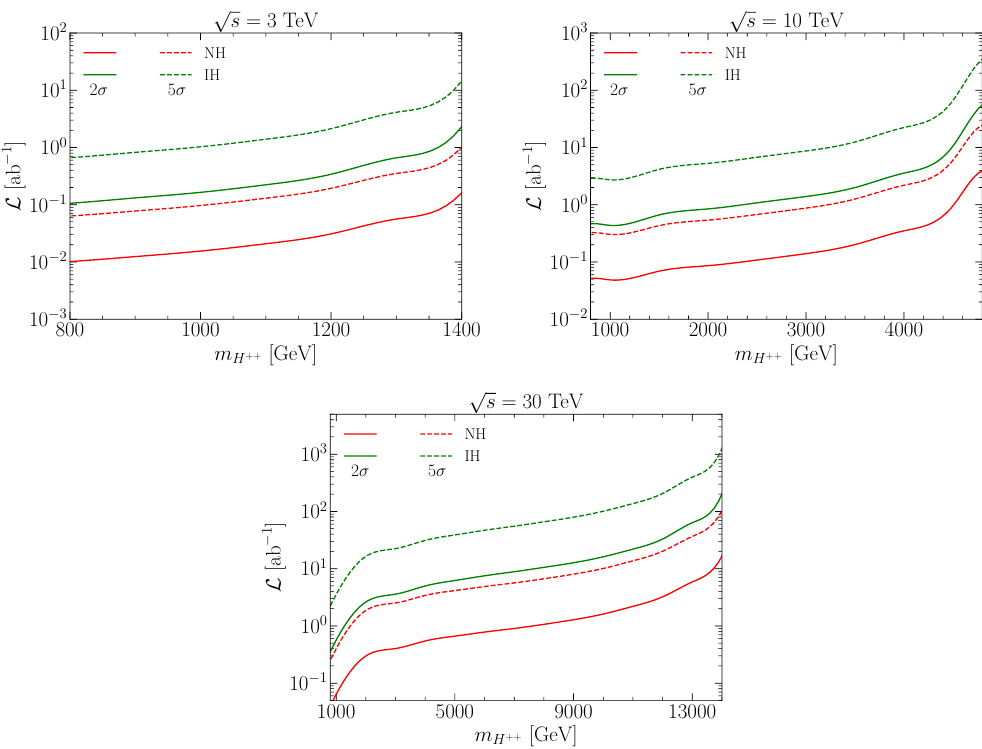
√ s = 3 TeV, 10 TeV and 30 TeV,